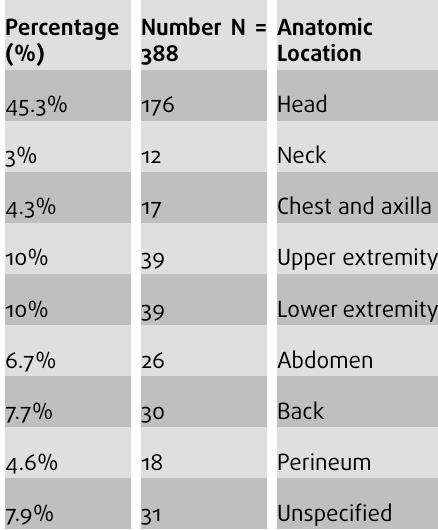
Table 3: Anatomic location of MN among patients attending KAAUH between January 2000 and December